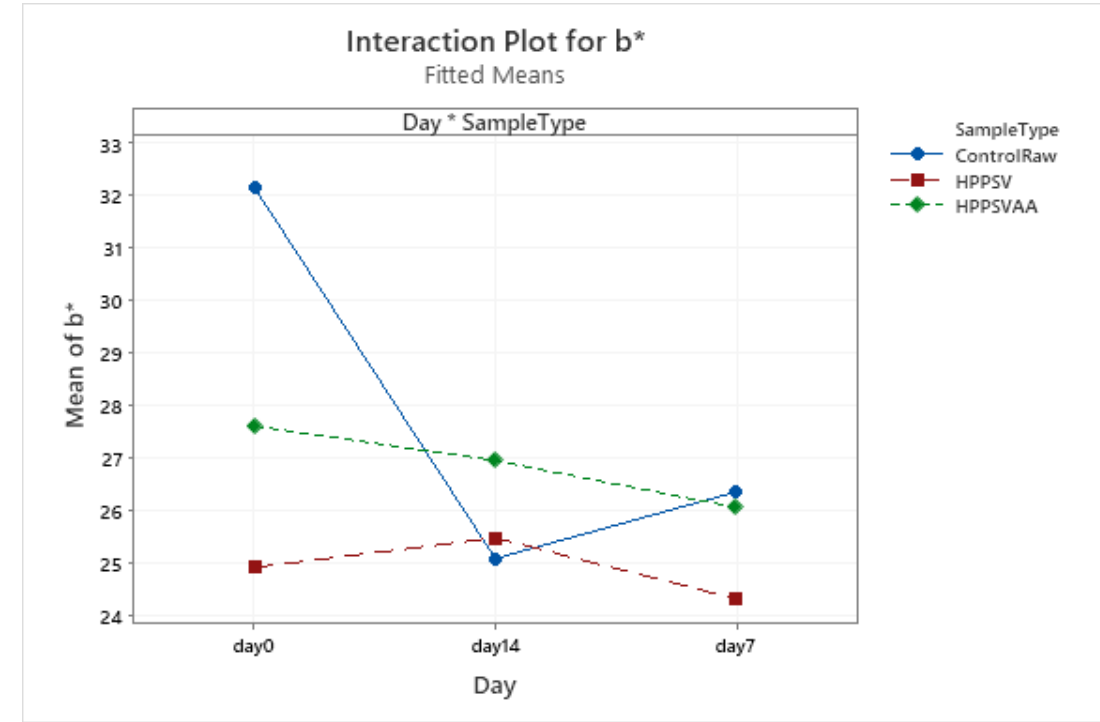
Figure A20. Effect of treatments and storage time on the a * coordinate of hybrid patty (HPPSV: HPP- SVCOOK).